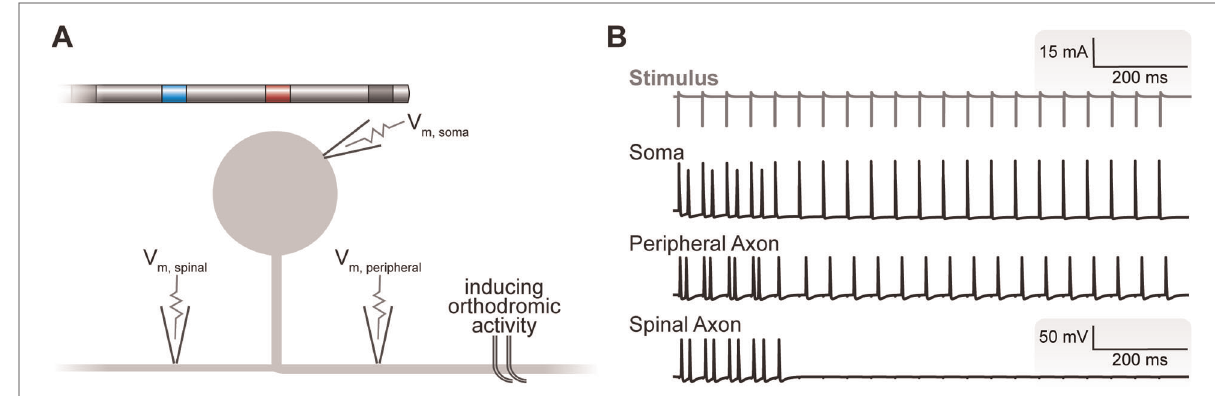
FIGURE 3 Simulating the neural response to DRGS. ( A ) We applied DRGS to each C-neuron model and recorded the resulting time-varying transmembrane voltages at the soma, peripheral axon, and spinal axon. In many cases, we were interested in how DRGS affected ongoing orthodromic activity (i.e., APs propagating from the peripheral axon, through the T-junction, to the spinal axon). A schematic of the four-contact DRGS electrode array is shown with the active contact (red) oriented above the soma of the model C-neuron (not to scale). ( B ) Time-varying transmembrane voltage traces in response to DRGS in a representative model C-neuron. The gray trace at the top represents the applied DRGS stimulus pulse. The black traces represent the time-varying membrane voltages of the soma, peripheral axon, and spinal axon. We initiated orthodromically propagating APs in the peripheral axon. Double APs are produced by closely timed APs generated by the DRGS pulse with those propagating orthodromically. In this representative neuron, suprathreshold DRGS induced T-junction fi ltering, blocking the propagation of APs into the spinal axon after a brief wash-in period putatively via the electrotonic spread of the slight hyperpolarization produced at the soma by